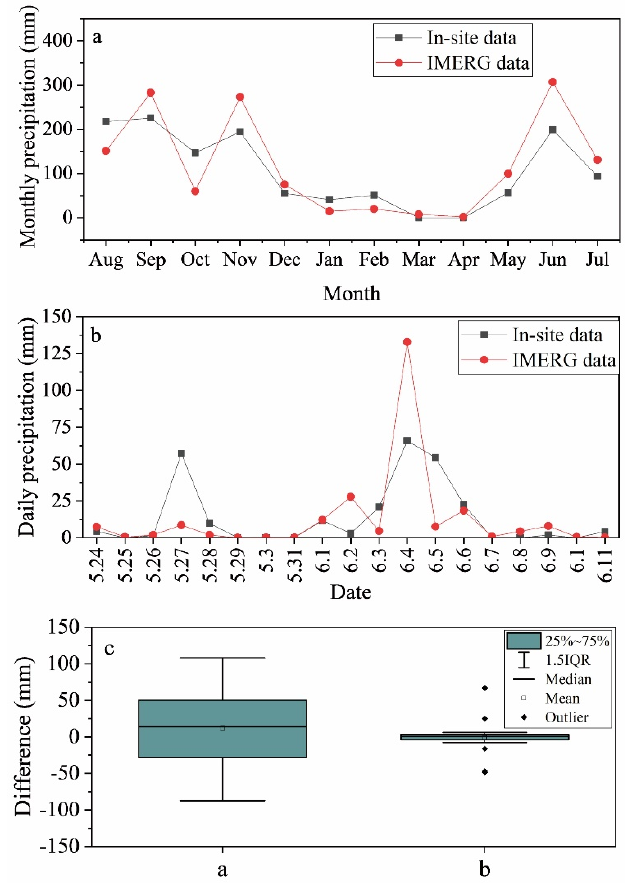
Figure 13. In situ and IMERG data of monthly precipitation in YS ( a ) and daily precipitation in MJ ( b ); the box plots indicate the differences between the in situ and IMERG data ( c ).